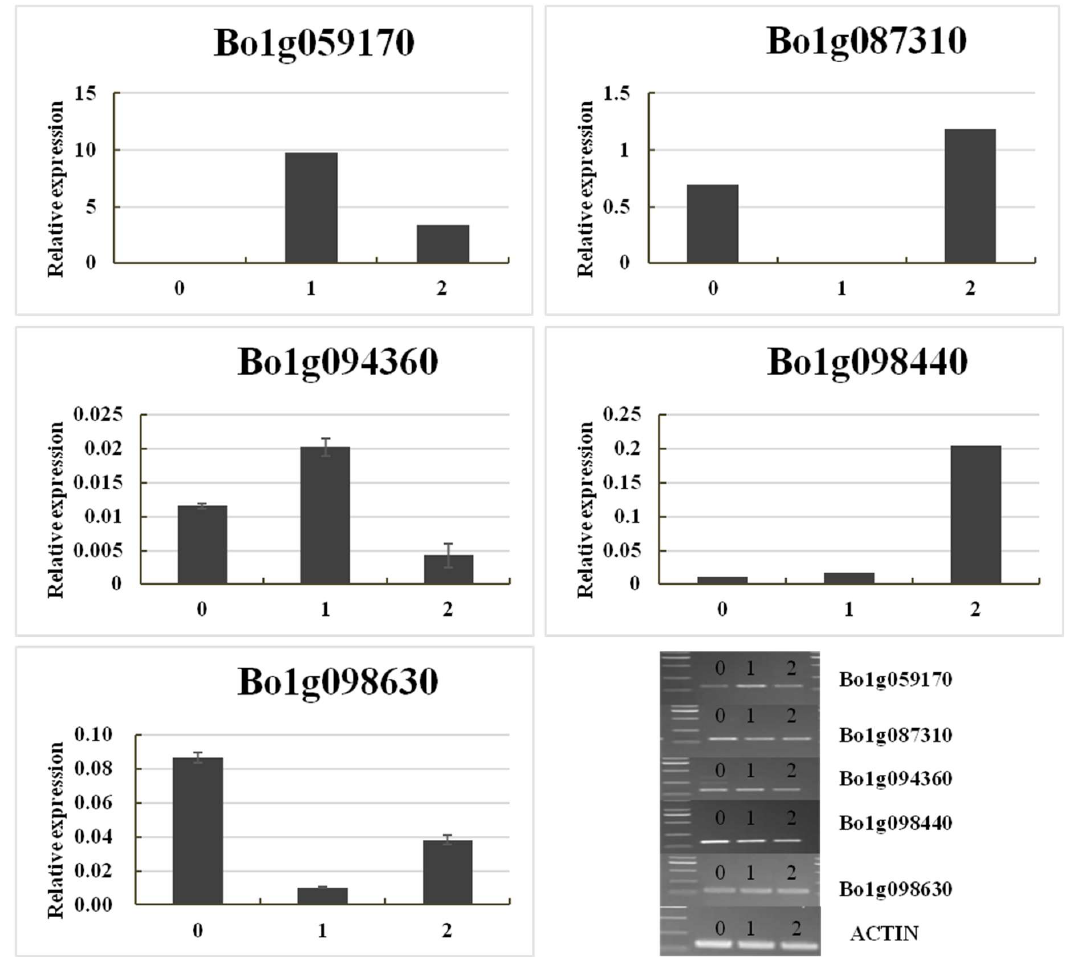
Figure 5 . qRT-PCR and RT-PCR validation of transcripts of five DEGs associated with the yellow-green-leaf mutant. 0: the parent 01-20, 1: Mutant YL-1, 2: the parent 11-192.